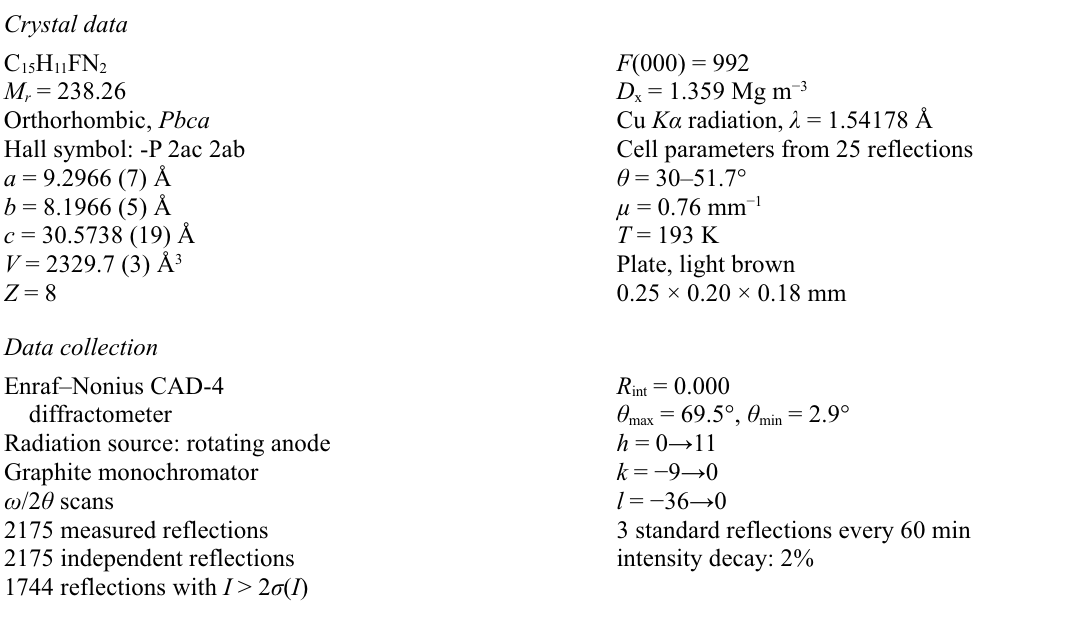
Crystal packing of the title compound. The hydrogen bond is shown with dashed lines. View along the b axis. 4-[2-(4-Fluorophenyl)-1 H